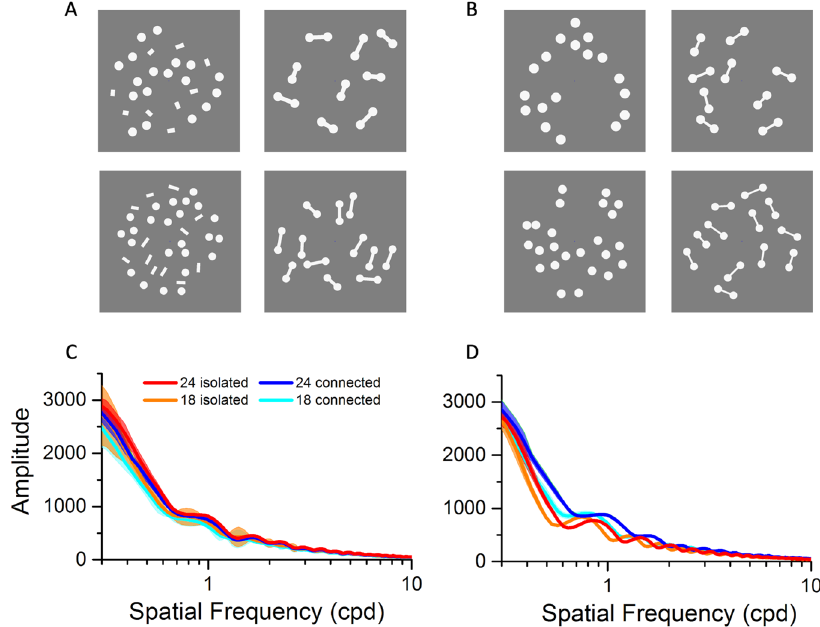
Fig. 1 Stimuli. A Examples of white stimuli used for experiment 1: stimuli comprised either 18 or 24 dots, which were either connected by lines or isolated, with the lines displaced to random positions. The stimuli with black dots were identical. Participants simply maintained gaze on a central fi xation point without performing any task, while the stimuli were displayed for 6 s. B Stimuli for experiment 2. The lines in the connected condition are thinner and in the isolated condition they are absorbed into the dots, which become slightly larger (about 40%). See “ Methods ” for further details. C Fourier amplitude (arbitrary units) of the stimuli of Fig. 1A, as a function of spatial frequency, over the range 0.3 – 10 cycles per degree. D Same as C , for the stimuli of Fig. 1B. Source data are provided as a Source Data fi